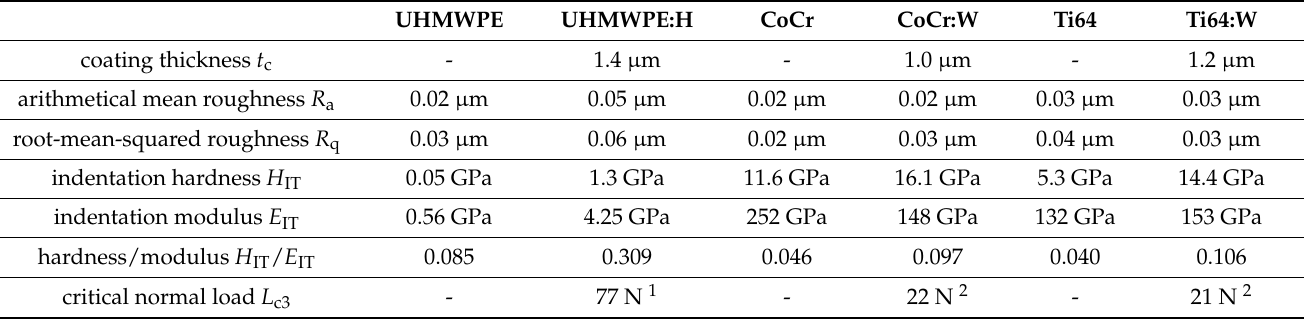
Table 1. Averaged key properties of the substrates and amorphous carbon coatings as determined in